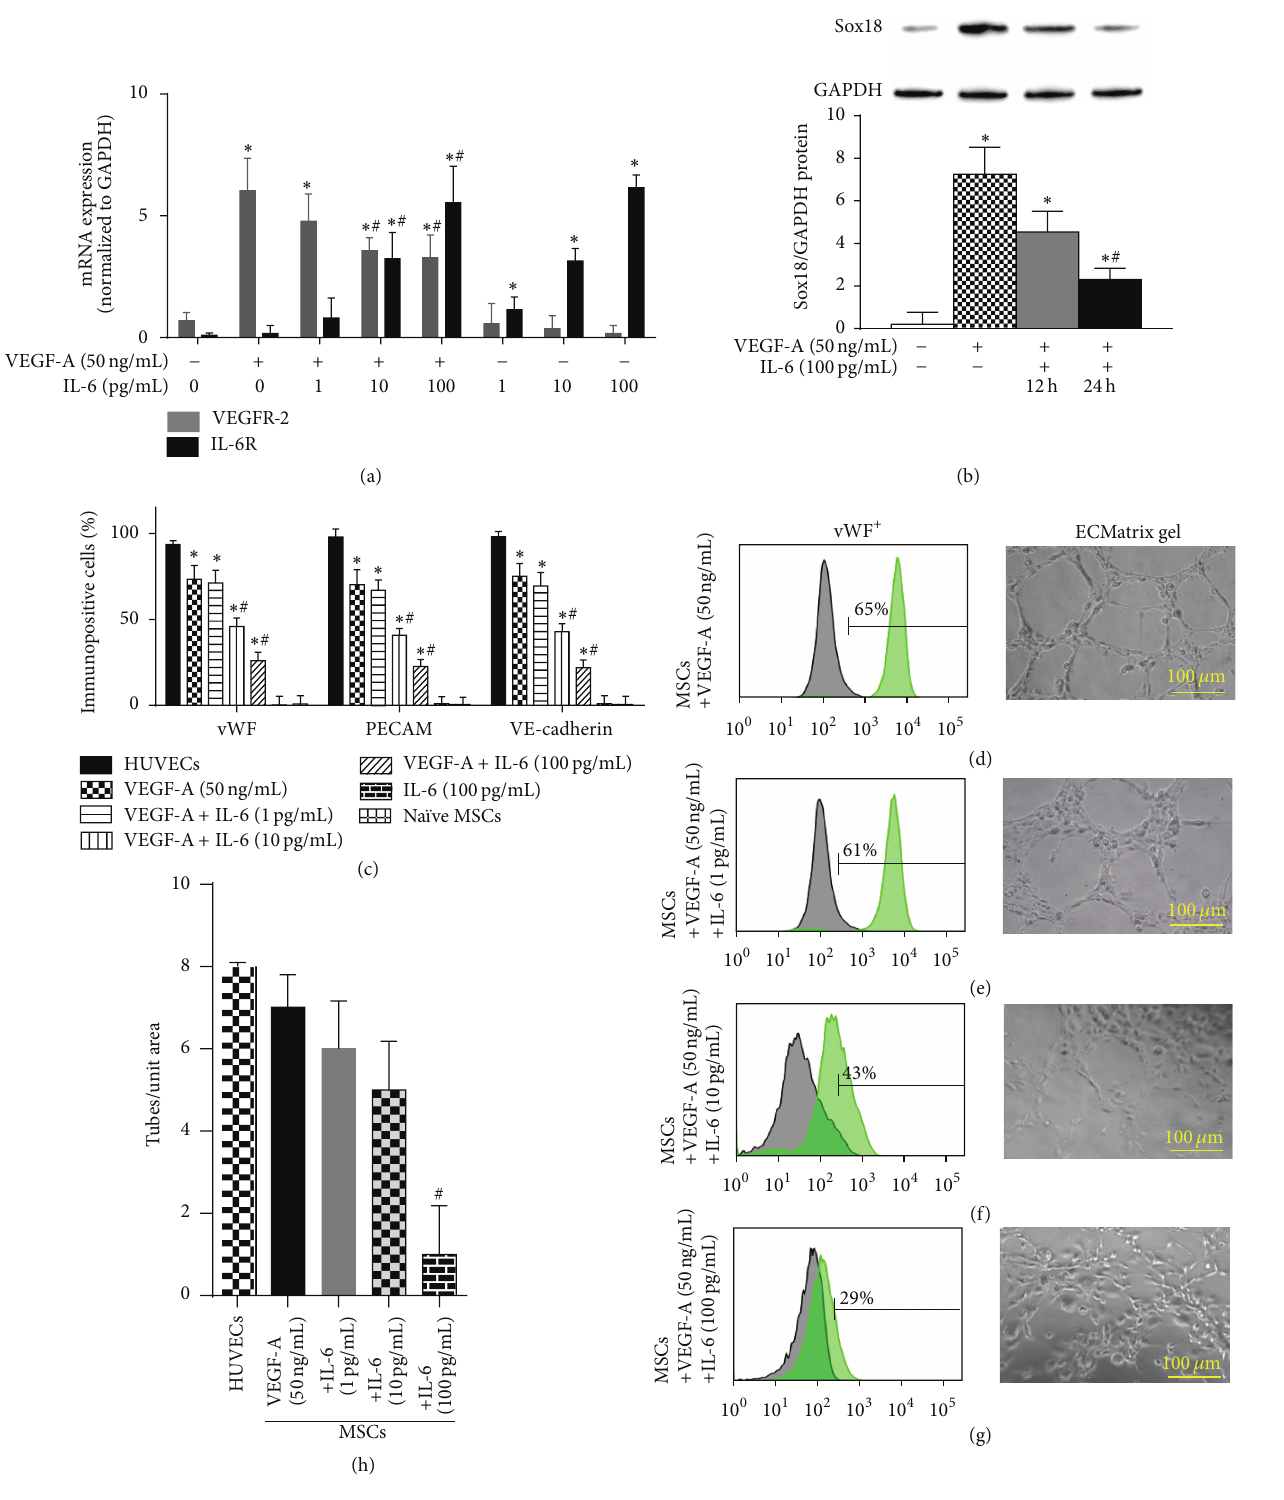
Figure 3: IL-6 negatively regulates EC differentiation: the effect of IL-6 on VEGF-A-stimulated differentiation of MSCs into ECs was examined. IL-6R and VEGFR-2 mRNA expression was analyzed by RT-PCR and normalized to GAPDH ( 𝑛 = 3 ) (a). Sox18 protein levels were measured by Western blot analysis and normalized to GAPDH ( 𝑛 = 3 ) (b). Expression of EC markers was determined by FACS analysis, and a representative grid is shown ( 𝑛 = 3–6) ((c)–(g)). Endothelial tube formation was examined using an angiogenesis assay ( 𝑛 = 3 ) ((d)–(h)). Experiments were performed with samples taken from independent BM-MSC cultures from separate microswine. HUVECs were excluded from statistical analyses. Data are shown as mean ± SD. ∗ 𝑝 < 0.05 versus na¨ıve MSCs and # 𝑝 < 0.05 MSCs treated with VEGF-A versus VEGF-A plus IL-6